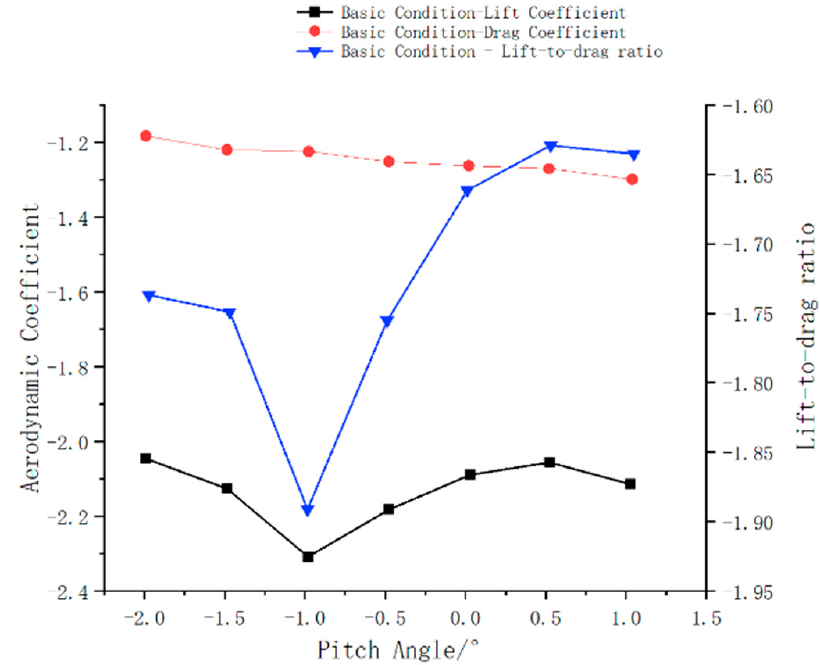
Figure 19. Curves of lift coefficient, drag coefficient and lift–drag ratio.